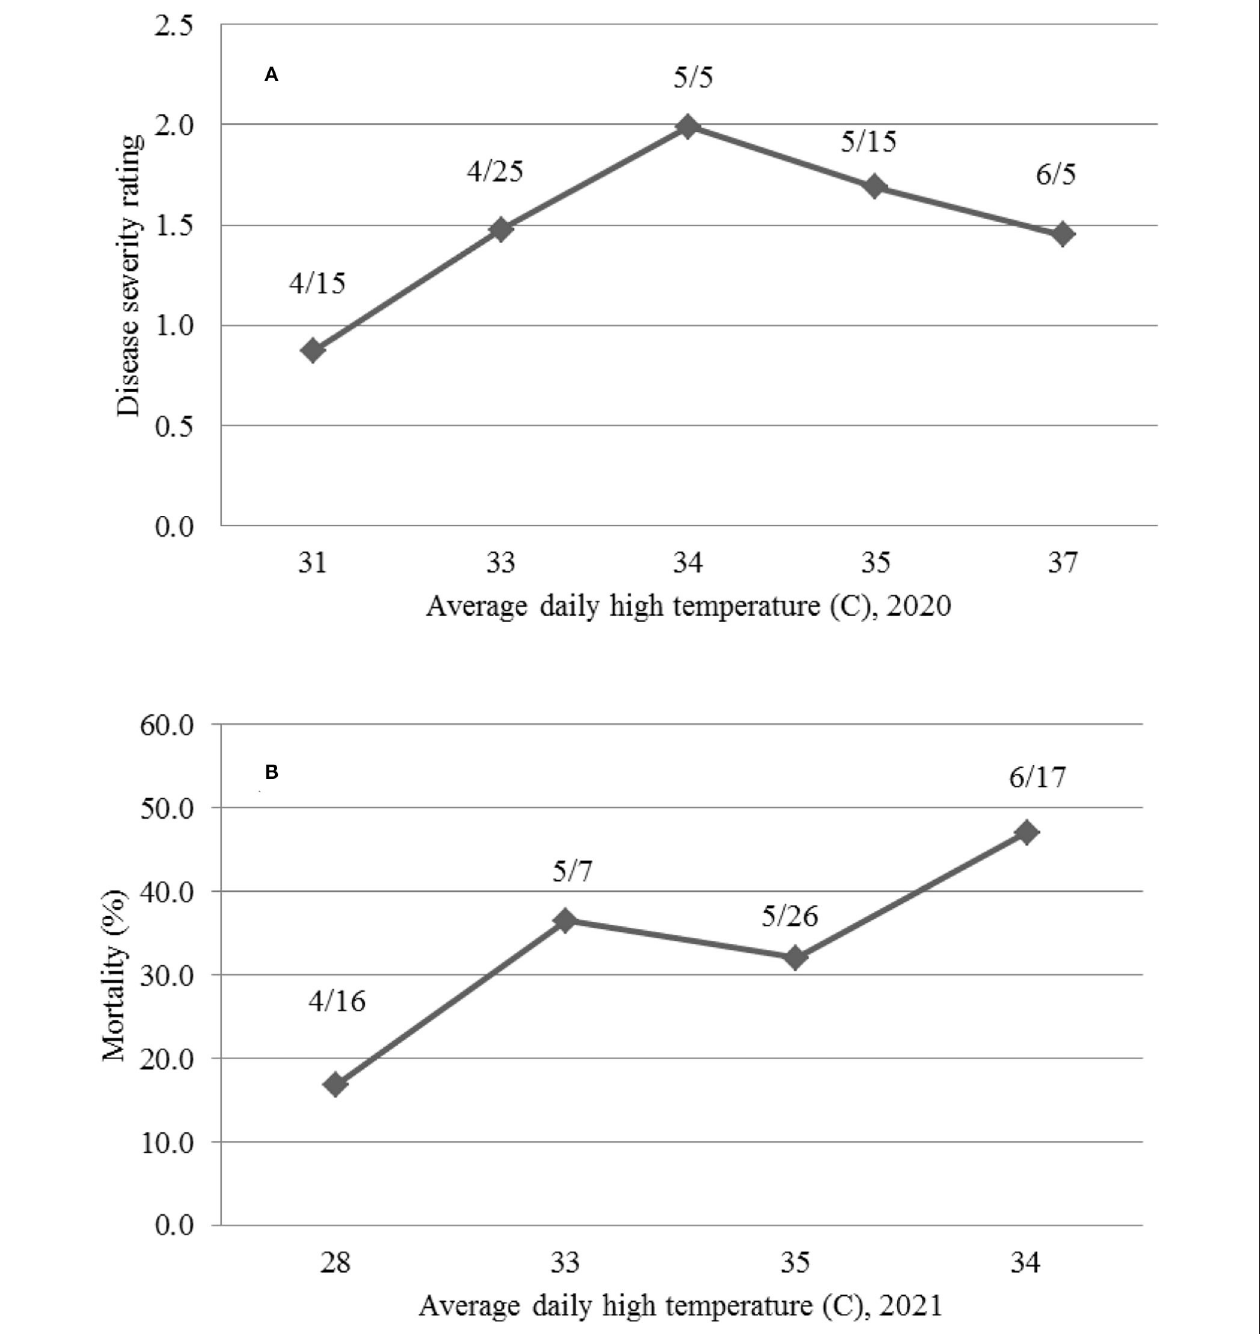
FIGURE 11 | The relationship between average daily temperature (C) and the mean disease severity rating (A) caused by Fusarium oxysporum f. sp. vasinfectum race 4 at 30 days post-inoculation (DPI) in 2020 and mean mortality (B) caused by Fusarium oxysporum f. sp. vasinfectum race 4 at 36 days after planting (DAP) in 2021 for different planting dates